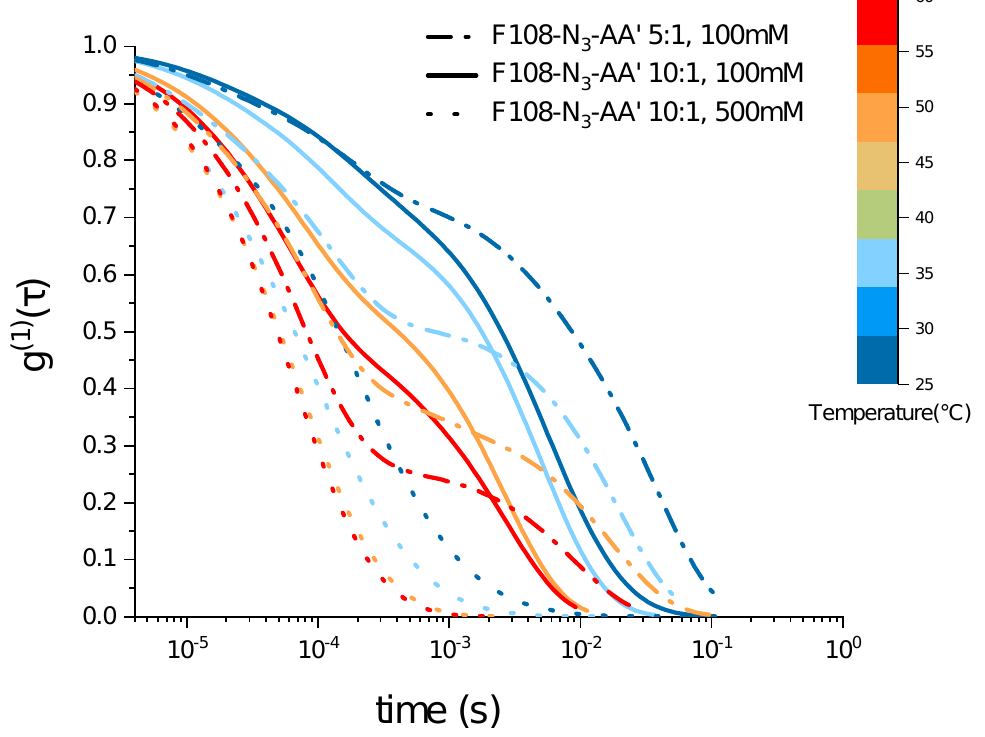
Figure 7. Electric field autocorrelation functions g ( 1 ) ( τ ) of 10%w/v F108-N 3 - AA (cid:48) with 10:1 and with 1:5 molar ratios as function of temperature and added NaCl measured in